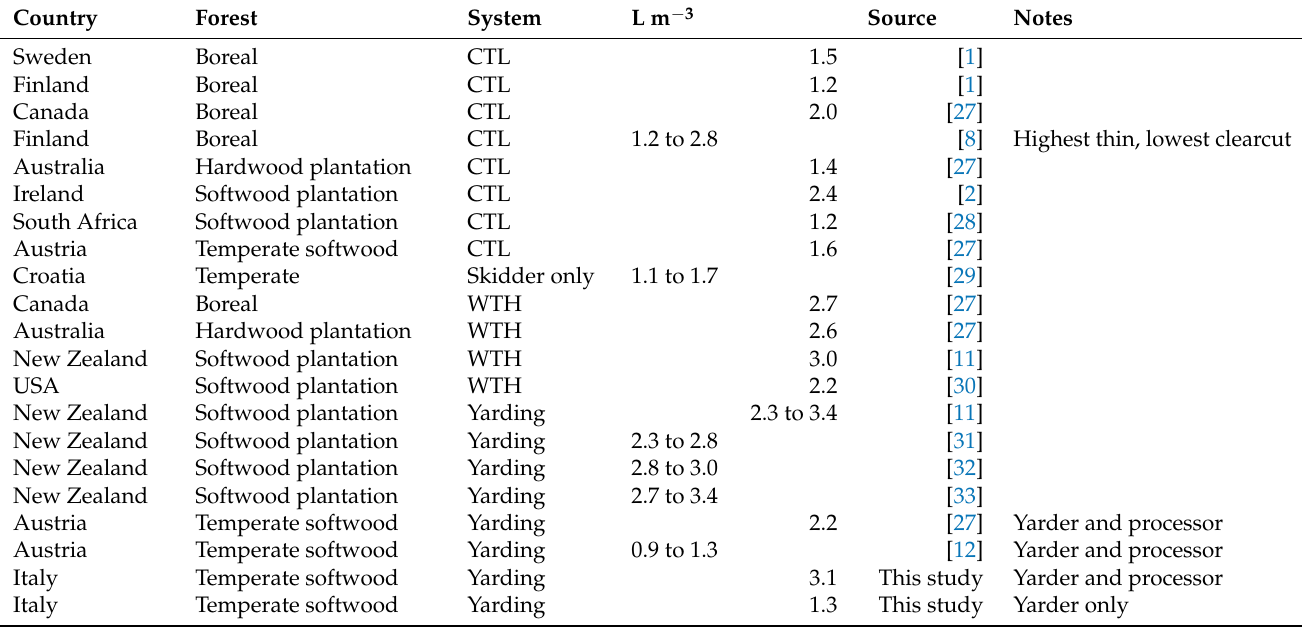
Table 9. Comparison with the results from other fuel consumption